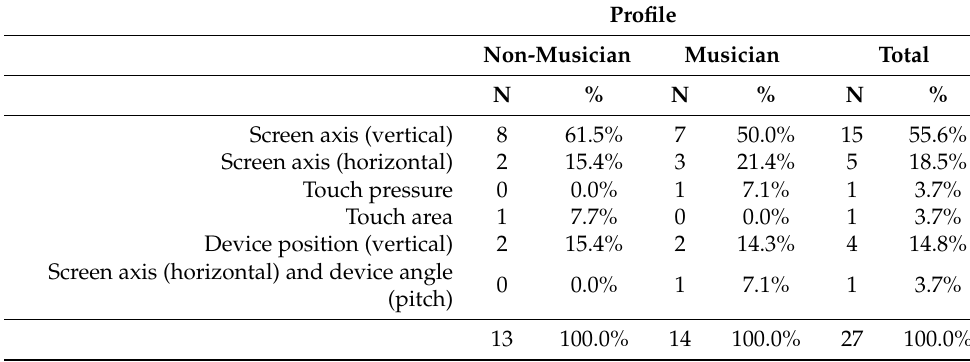
Table A13. Pitch variation mapping (uncategorized)—stimulus d.